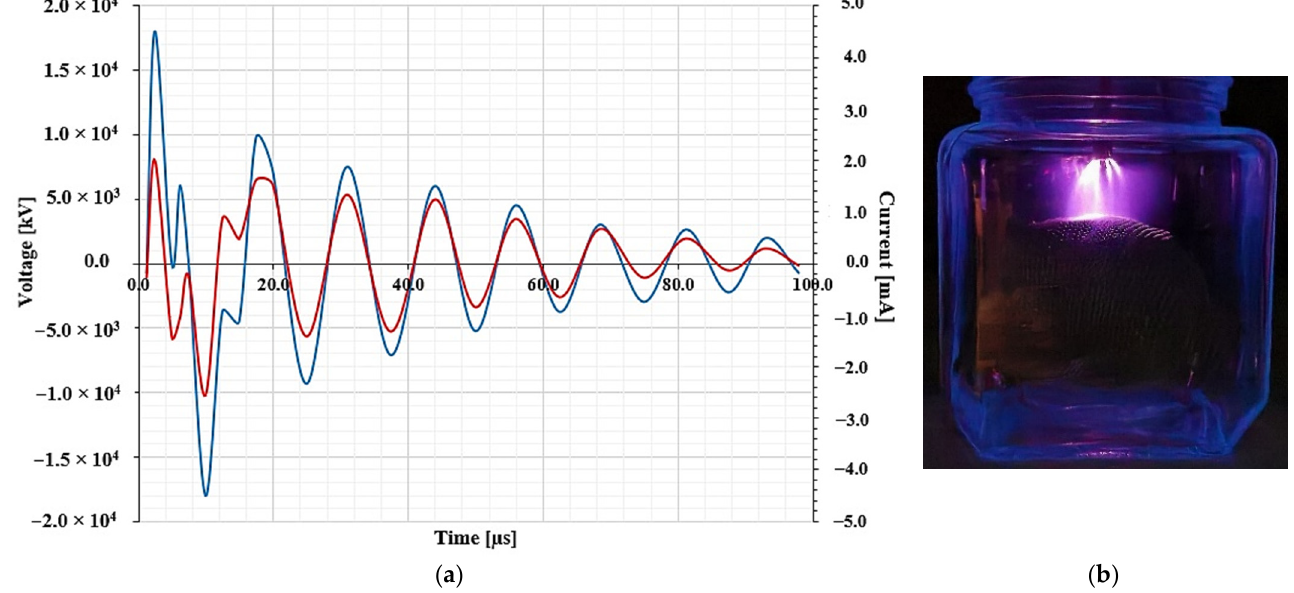
Figure 3. Waveform registered experimentally ( a ) as a result of corona discharge ( b ) to stimulate the growth of lentil structures.